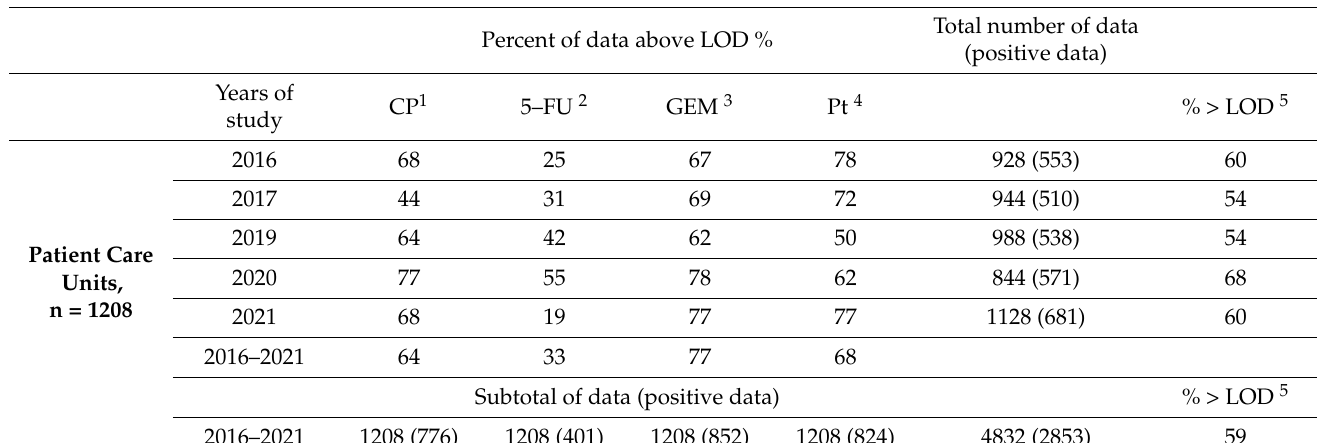
Total Number of Data (Positive